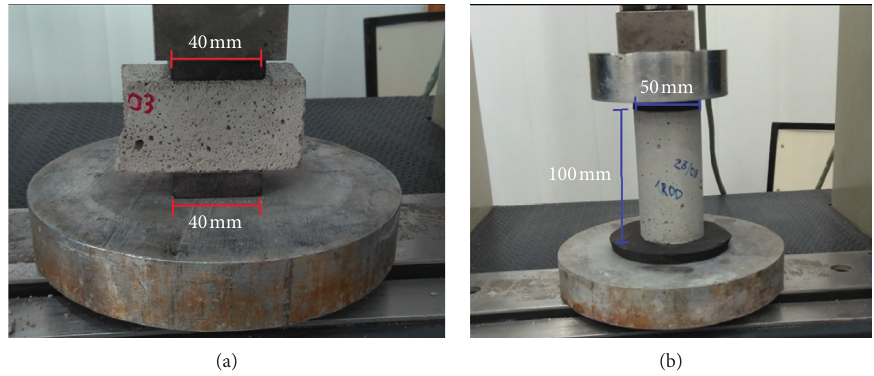
Figure 2: Illustration of compression test for both (a) prismatic and (b) cylindrical specimens.